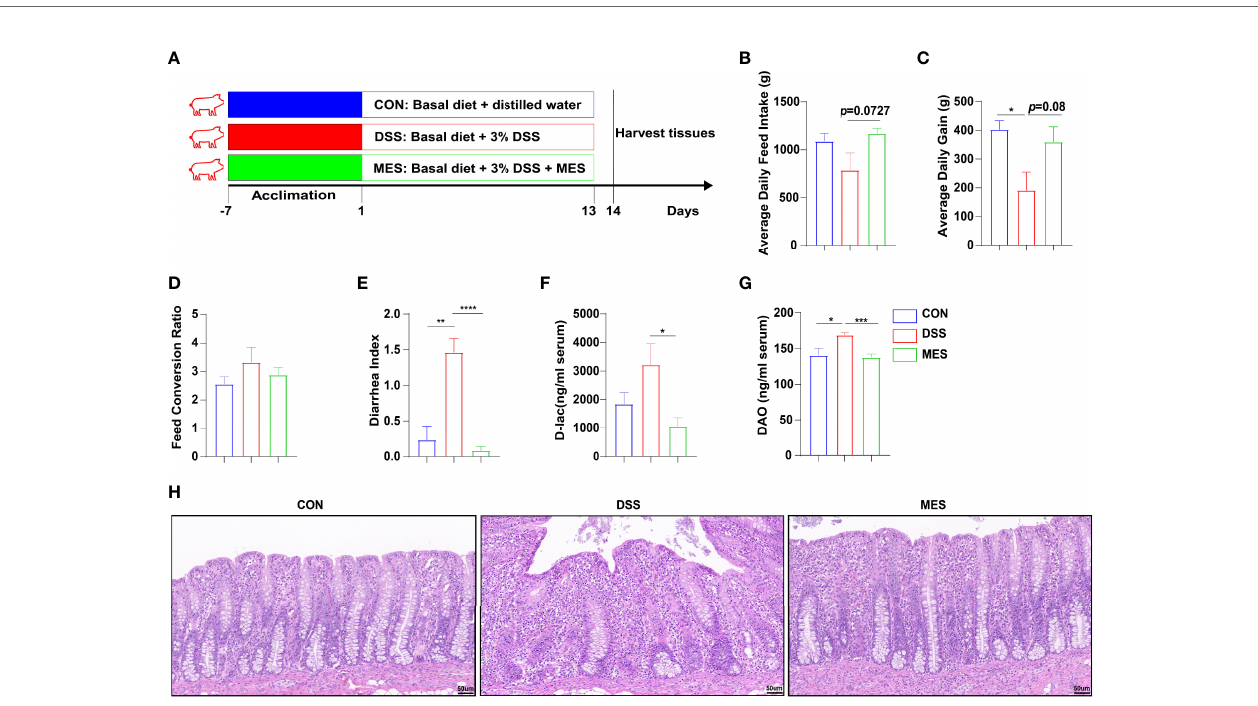
FIGURE 1 | MES alleviates DSS-induced colitis in piglets. (A) Schematic diagram of the colitis model of weaned piglets used in this study; (B) average daily feed intake, (C) average daily gain, and (D) feed conversion rate during DSS treatment; (E) diarrhea index; (F) serum levels of D-lactic acid and (G) serum diamine oxidase; (H) H&E-stained colon sections. Scale bar = 50 µm. Data were presented as mean ± SEM (n = 6 per group). Statistical signi fi cance was determined using one-way ANOVA, followed by Tukey test. * P < 0.05, ** P < 0.01, *** P < 0.001, **** P <